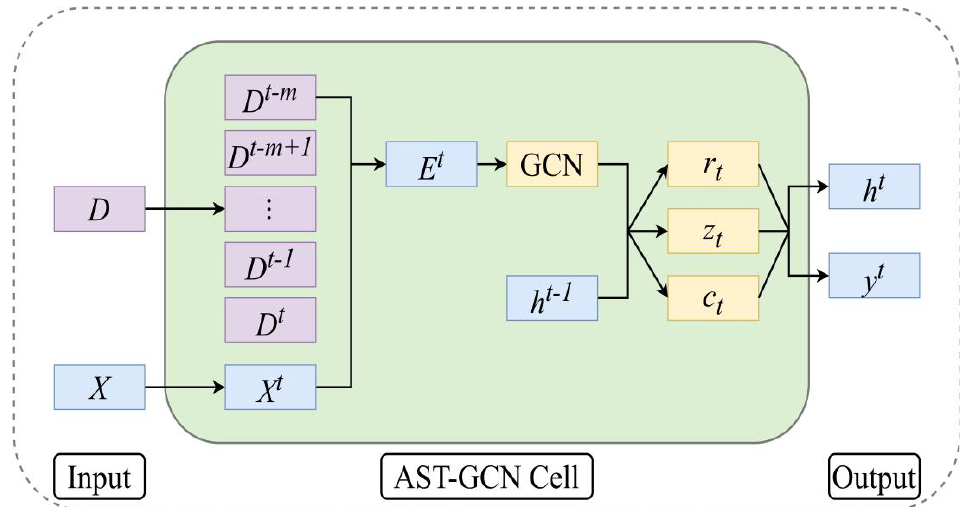
Figure 2. The architecture of an AST-GCN cell.